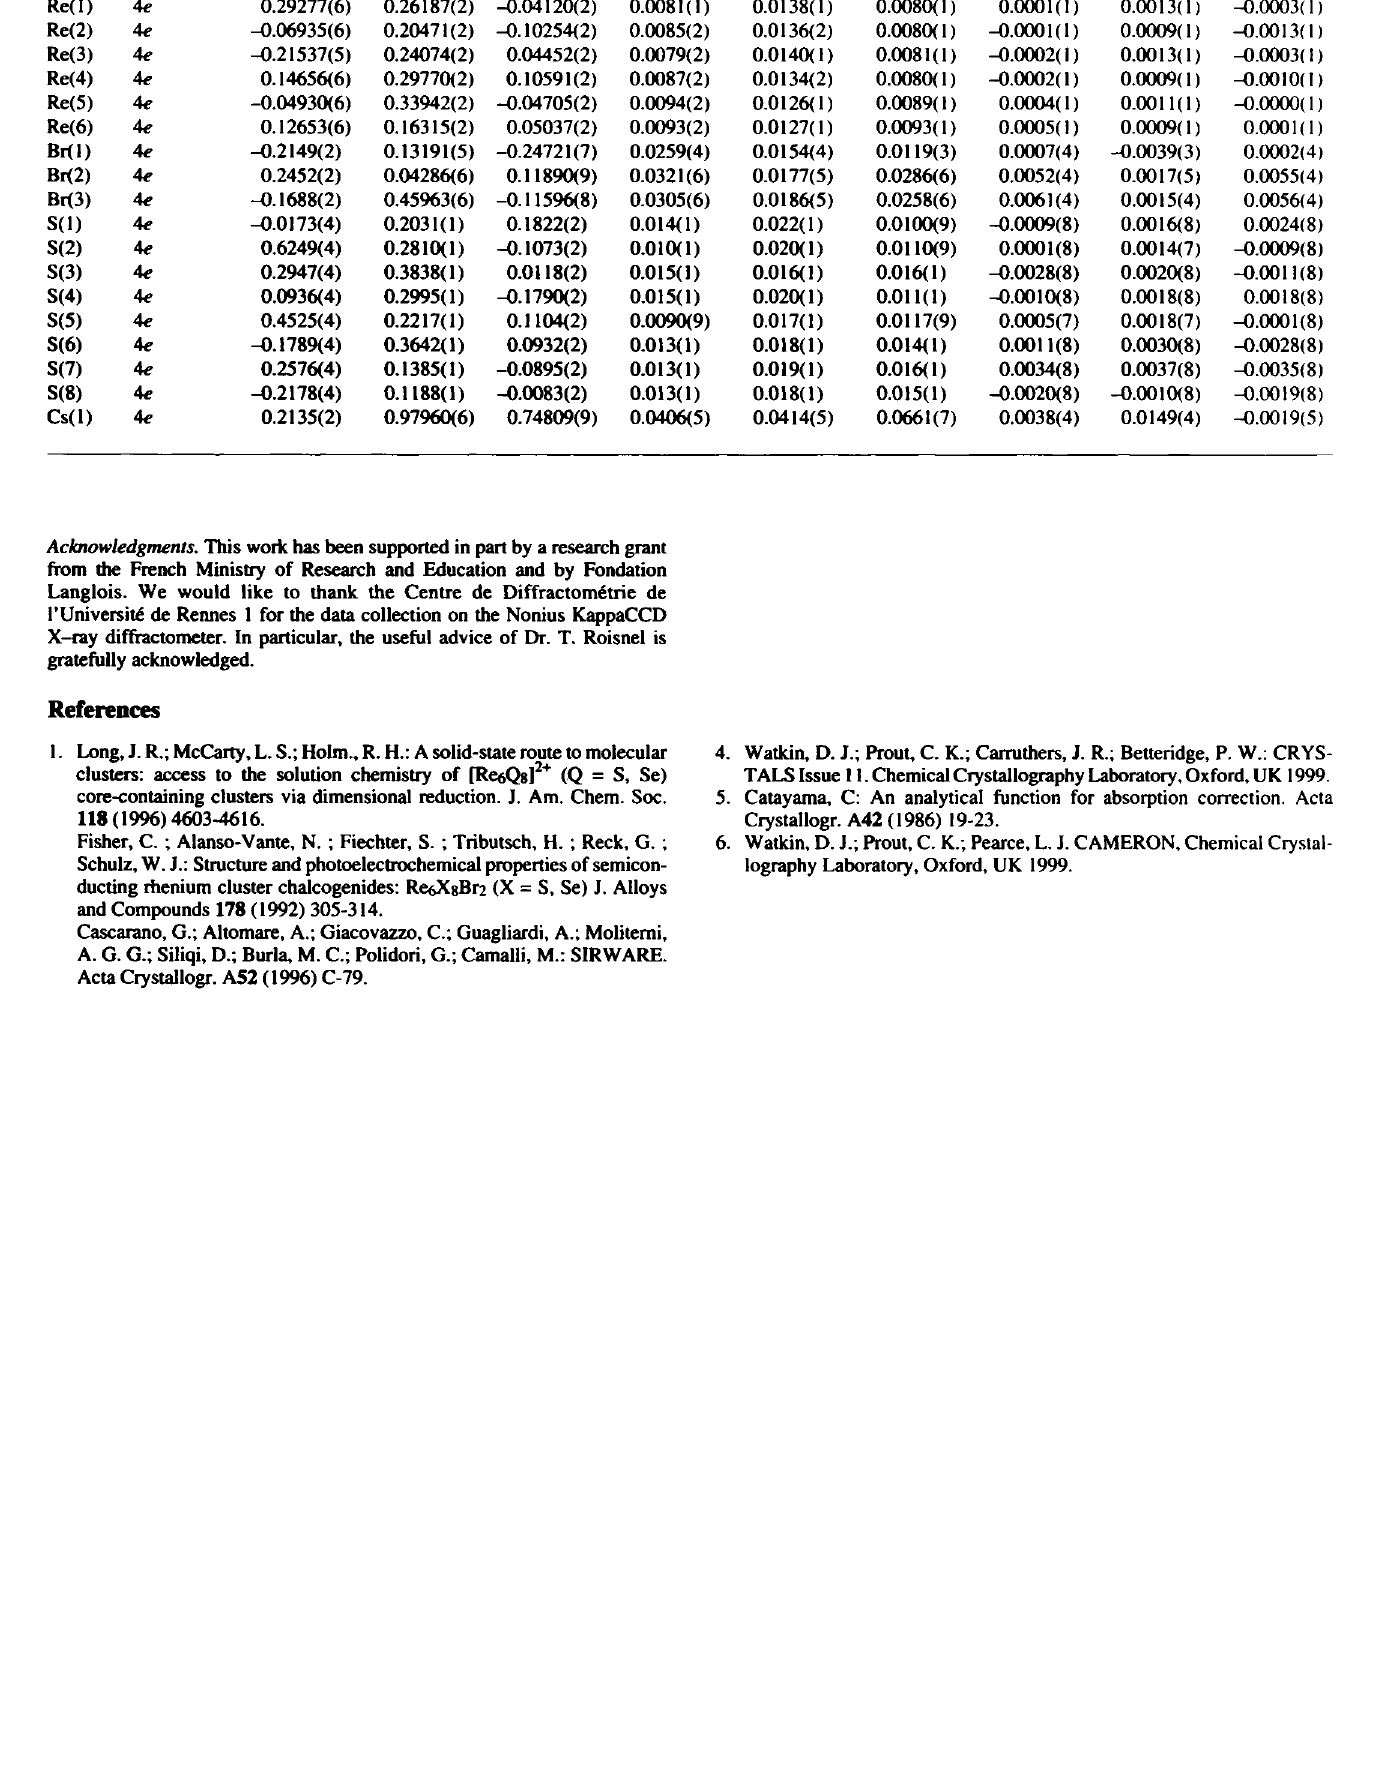
Table 2. Atomic coordinates and displacement parameters (in Â 2